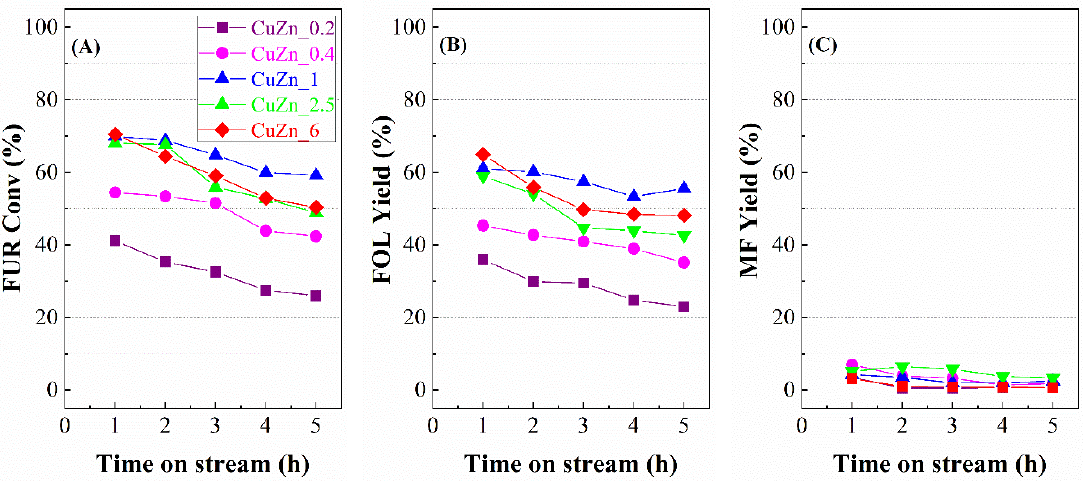
Figure 9. FUR conversion ( A ), FOL yield ( B ), and MF yield ( C ) in the FUR hydrogenation over CuZn_X catalysts (Experimental conditions: Mass of catalyst = 0.15 g, Reaction temperature = 190 °C, Pressure = 0.1 MPa, H 2 flow = 10 mL min −1 , Fed flow = 2.3 mmol FUR h −1 ).